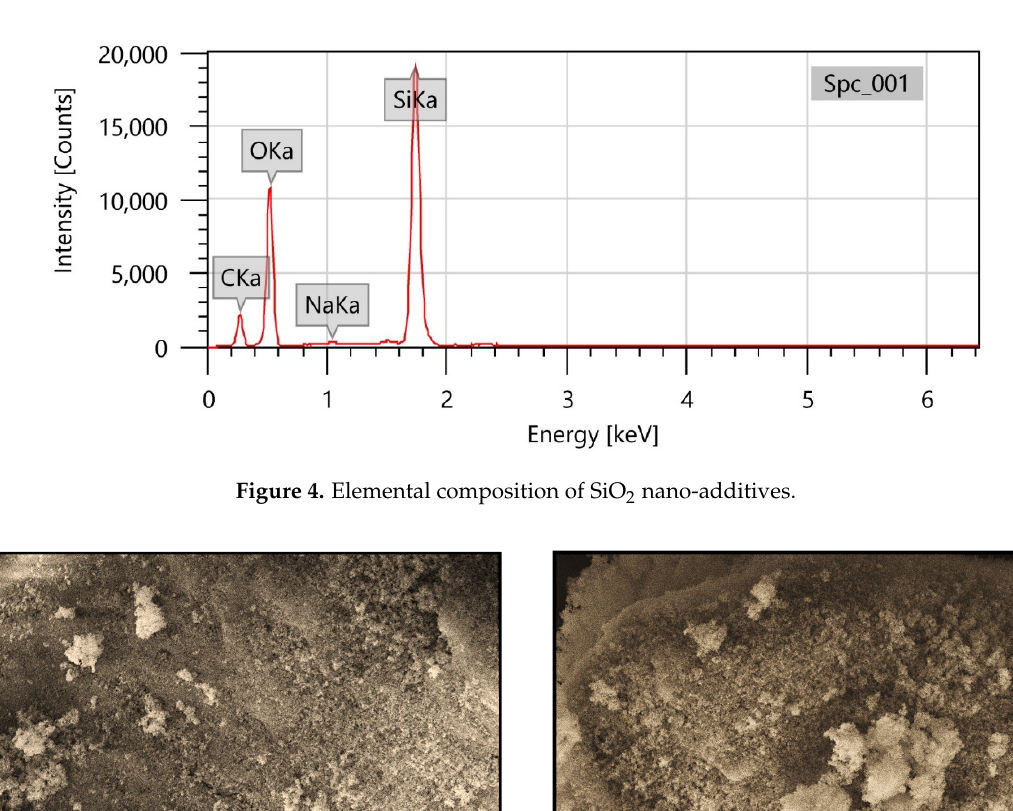
Figure 3. Crystalline structure of nano-additives, including measurement conditions.